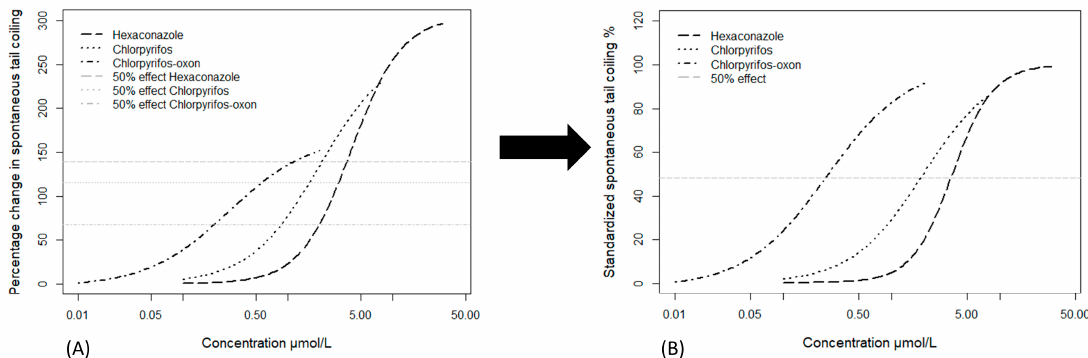
Figure 2. Visual representation of the data transformation for hyperactivity-inducing chemicals: ( A ) Concentration response curves showing different maximal for the hyperactivity inducing substances. The horizontal lines show EC 50 , EC 41 and EC 24 which corresponds to the 50% effect for hexaconazole, chlorpyrifos and chlorpyrifos-oxon respectively; ( B ) Standardized concentration–response curves for the hyperactivity substances. The horizontal line shows the same 50% effect for the 3 substances after standardization. Data taken from Ogungbemi et al. (2020)